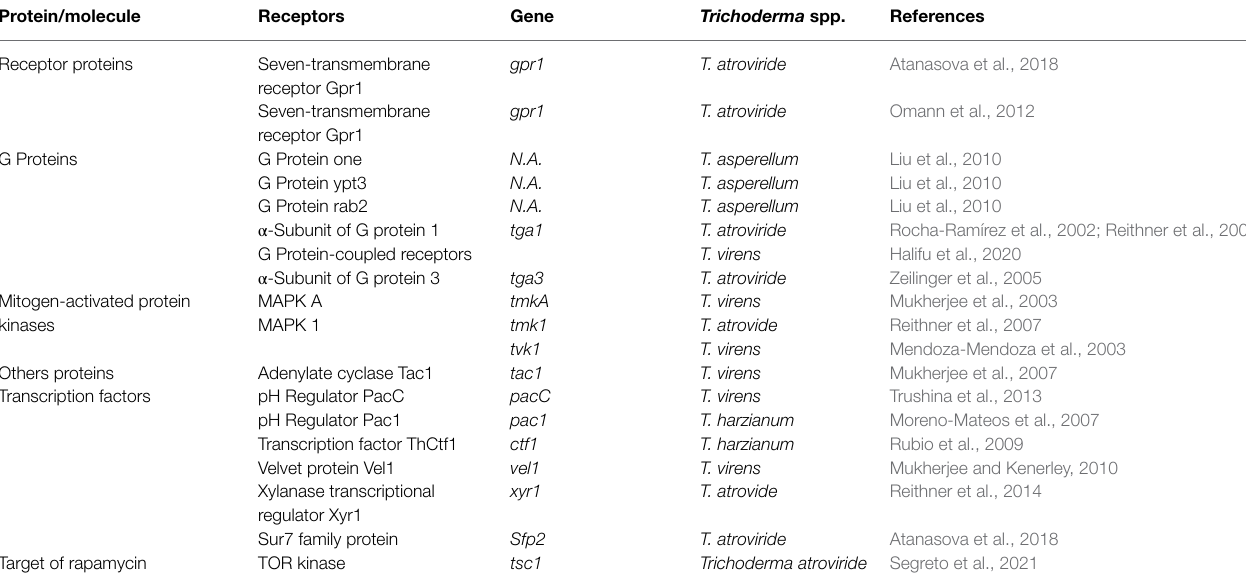
TABLE 1 | Role of Trichoderma spp. genes involved in recognition of R. solani and signal transduction.